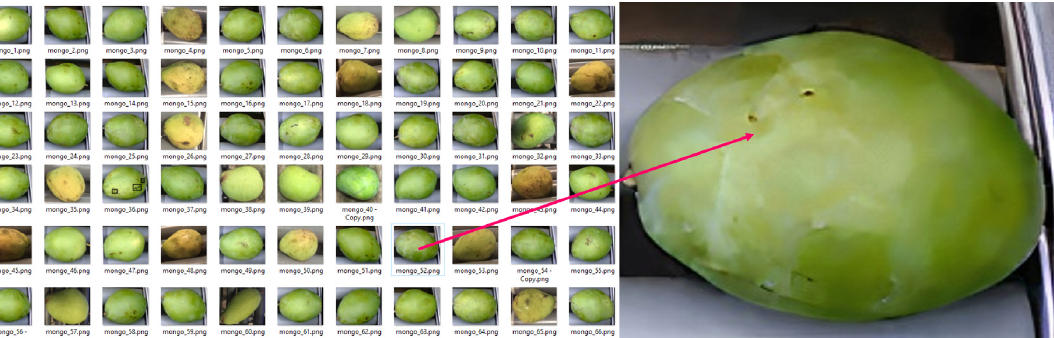
Figure 7. Images taken from mangoes of one local species.